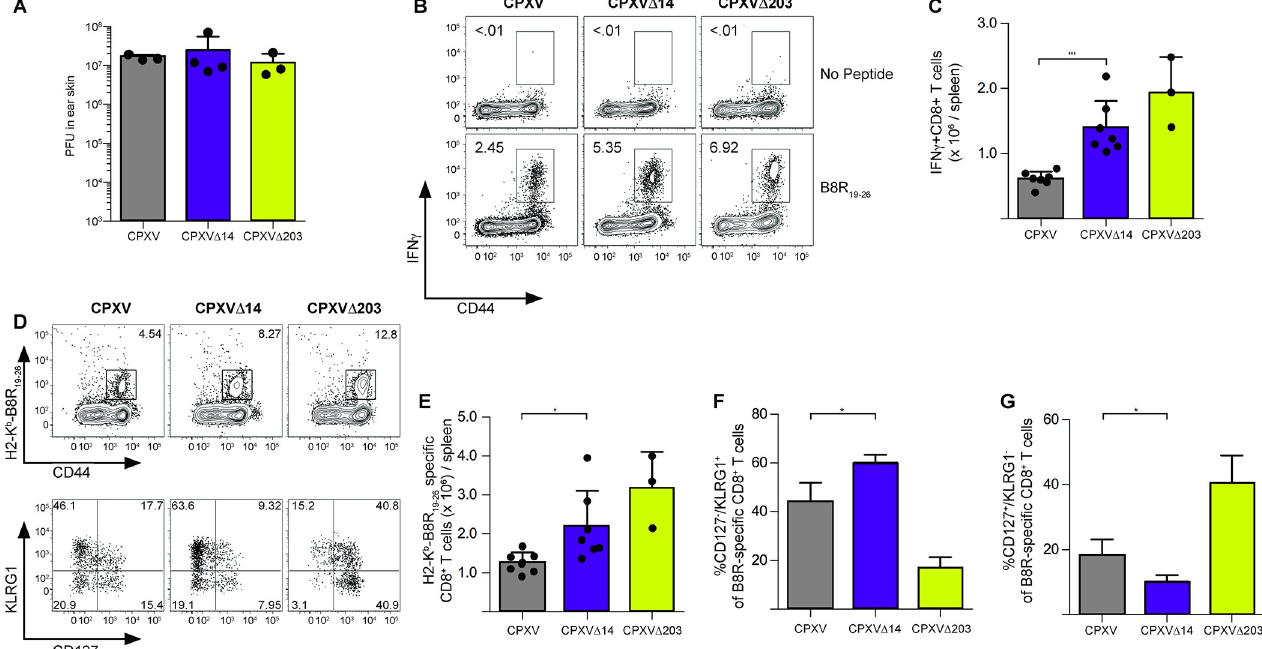
Fig 9. Deletion of CPXV14 increases CPXV-specific CD8+ T cell responses in vivo . A) Deletion of CPXV14 or CPXV203 does not impact local replication. The left ears of C57BL/6J B6 mice were inoculated by scarification with 1 x 10 5 PFU of CPXV (n = 3), CPXV Δ 14 (n = 4), or CPXV Δ 203 (n = 3). On day 10 post- infection, viral load in the infected ear was quantified using standard plaque assay. B) Increased CPXV-specific T cell responses upon deletion of CPXV14 or CPXV203. Infection with the indicated viruses was performed as in (A). On day 10 post-infection, splenocytes were stimulated with B8R 19-26 peptide for 5h and IFN γ expression was analyzed by ICS. C) Quantification of (B) for CPXV (n = 7), CPXV Δ 14 (n = 7) or CPXV Δ 203 (n = 3). D) T cell phenotyping of CPXV- specific T cell response. The experiment was performed as in (B) except that B8R 19-26 -specific CD8+ T cells were identified with MHC-I tetramers and expression of CD127 and KLRG1 was analyzed. E) Quantification of total B8R-specific CD8+ T cells from (D); CPXV (n = 7), CPXV Δ 14 (n = 7) or CPXV Δ 203 (n = 3). F & G) Quantification of CD8+ T cell phenotypes from (D) for terminally differentiated effectors (CD127-/KLRG1+) (F) or memory precursor cells (CD127+/KLRG1-) (F). For all charts shown in Fig 8 statistical significance was determined using 2-way ANOVA with Tukey’s post-test ( � p � 0.05, �� p � 0.01, �� p � 0.001).